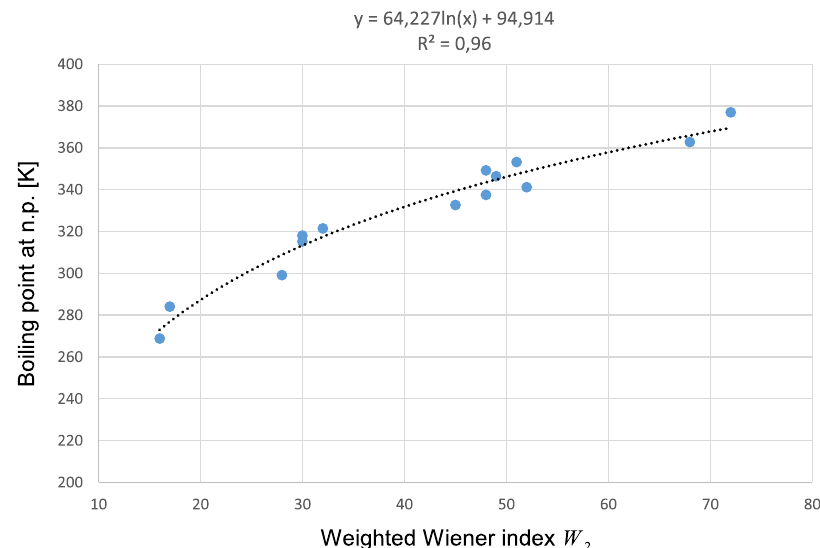
Figure 7. Weighted Wiener indices W 2 and boiling points for the unbranched alkadienes.